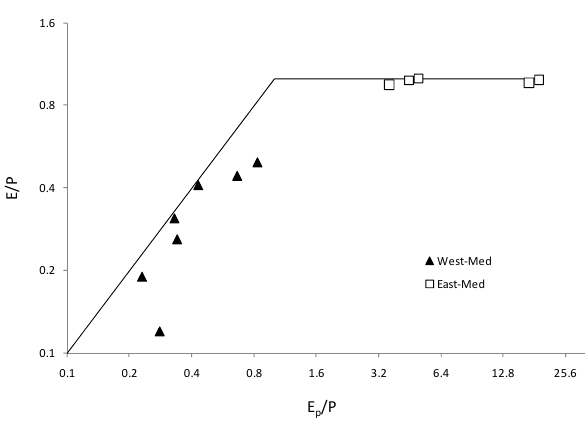
Fig. 4. Budyko diagram.